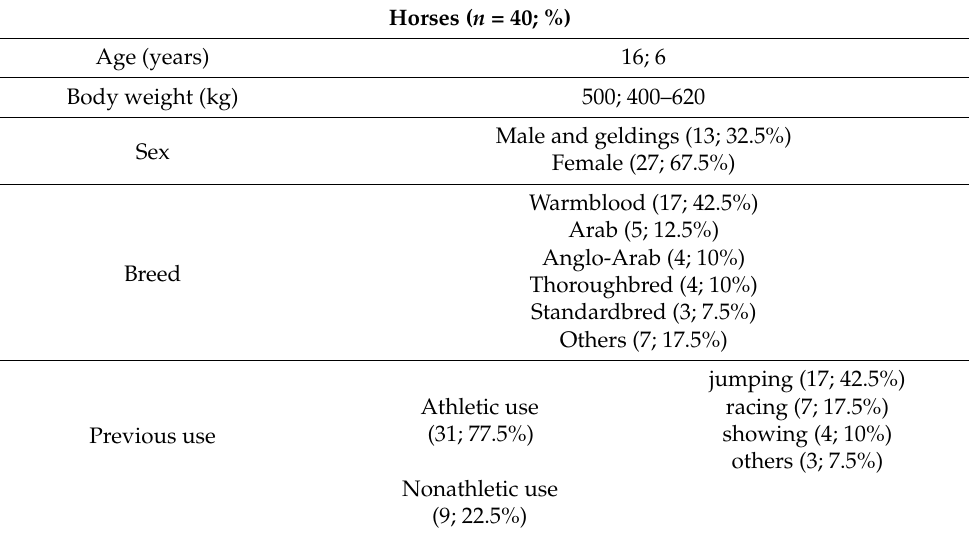
Table 1. Age (mean and standard deviation) and body weight (median and ranges), number ( n ), and prevalence (%) of sex distribution, breed, and previous use for 40 specimens that underwent post-mortem computed tomographic evaluation of the caudal lumbar